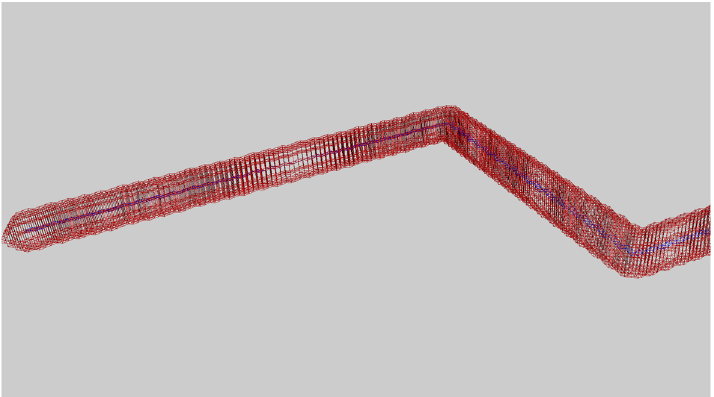
Figure 6. The 3D buffer of a line. Cells marked as the target line are shown in blue, and cells marked as the buffer are shown in red. as the buffer are shown in